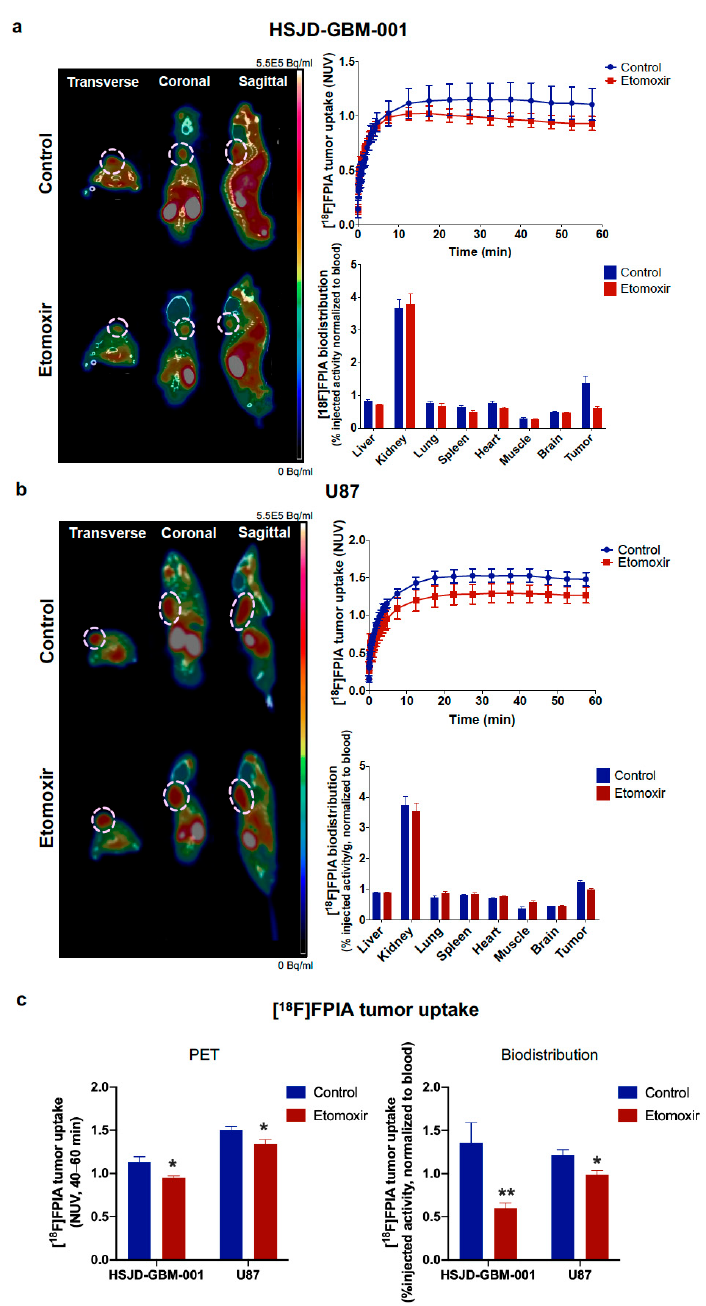
Figure 4. Effect of etomoxir on [ 18 F]FPIA uptake in subcutaneous HSJD-GBM-001 and U87 glioma xenografts. [ 18 F]FPIA uptake was evaluated in control and etomoxir-treated mice using PET imaging and ex vivo biodistribution studies. Representative PET images, tumor time activity curves (NUVs) and biodistribution (%injected radioactivity/g normalized to blood, ex-vivo γ -counting) of [ 18 F]FPIA in ( a ) U87 and ( b ) HSJD-GBM-001 tumors, and ( c ) [ 18 F]FPIA tumor uptake (NUVs, 40–60 min and %injected activity/g normalized to blood) in control and etomoxir-treated mice. Treatment with etomoxir significantly decreased [ 18 F]FPIA uptake (NUVs, 40–60 min and % injected radioactivity/g, * p = 0.01 and ** p < 0.005, respectively, Student’s t tests) in both HSJD-GBM-001 and U87 tumors. No significant changes in radiotracer uptake were observed in the blood or any of the other tissues examined in response to